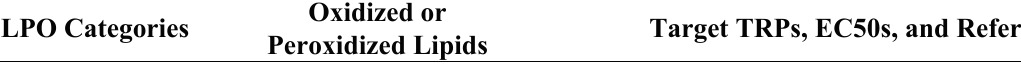
Table 1. List of the lipid peroxidation (LPO) products that activate sensory transient receptor potential (TRP)